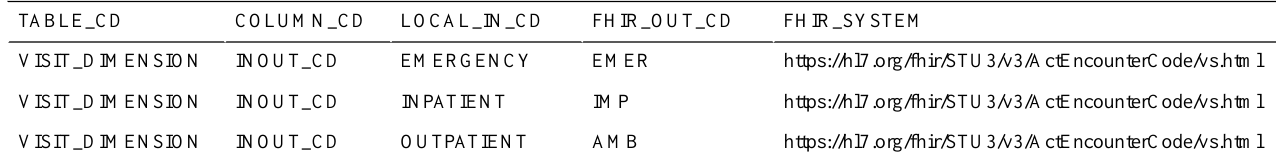
Table 2. Excerpt from University of North Carolina’s Informatics for Integrating Biology and the Bedside-Fast Healthcare Interoperability Resources mapping